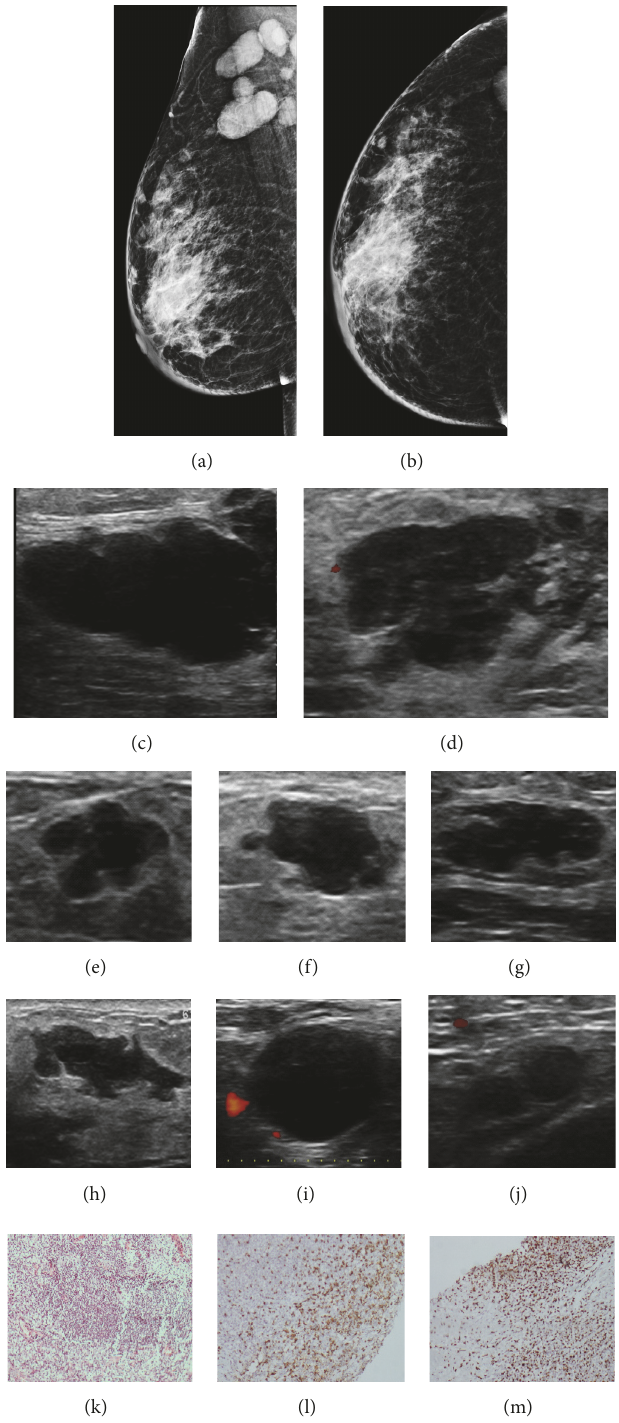
Figure 9: Case9. A 62-year-old woman with large B-cell lymphoma of germinal centerorigin. The patient was admitted to our institution for 3 months given the presence of a palpable mass in the right breast ( a–b ). On mammography, multiple focal asymmetries in the retroareolar region were noted. Additionally, mammograms showed skin thickening and oval masses located on the upper-outer quadrant that were isodense and featured circumscribed margins ( c–h ). Multiple irregular masses with multilobulated margins and heterogeneousecho patterns were observed on ultrasound ( i–j ). Both axillary and infraclavicular adenopathies were noticed. HE staining and immunohistochemistry analysis of the metastases. HE staining revealed the malignant cells in the breast tumor ( k ), and the immunohistochemistryanalysis indicated that the cells were positive for CD20 ( l ). Additionally, it is shown that Ki-67 protein was expressed in 70% of the tumor cells ( m